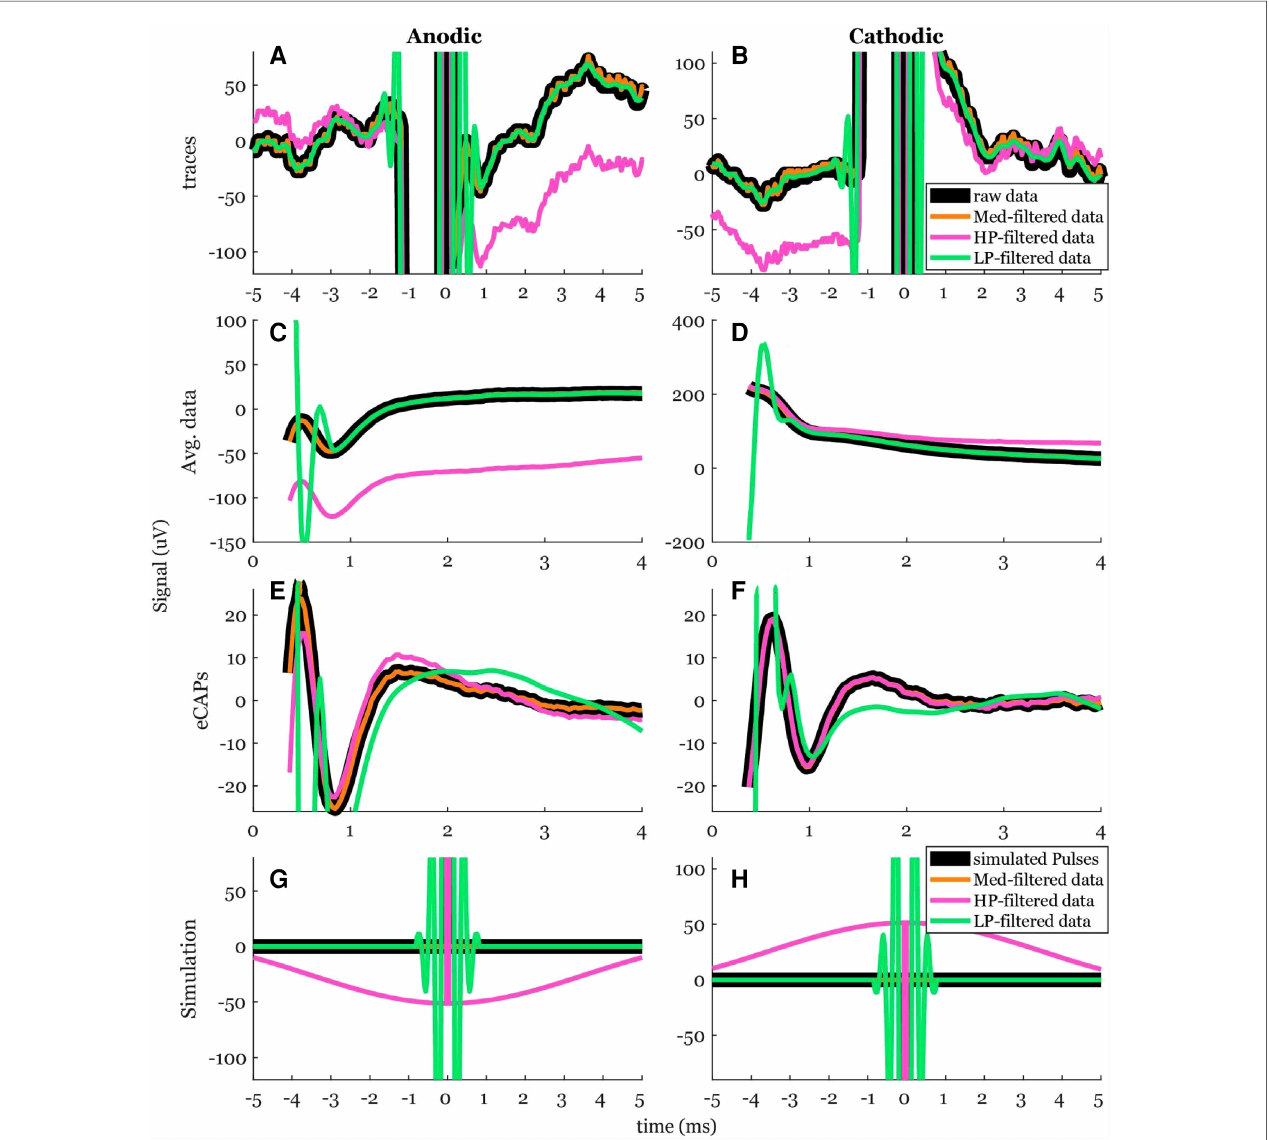
FIGURE 7 The effects of using of fl ine digital fi lters: a median (Med) fi lter with a 100-ms window, a 4th order Butterworth high pass (HP) fi lter with 80-Hz cutoff frequency applied in forward and reverse, and a 50-tap FIR low pass (LP) fi lter with 3 kHz cutoff frequency. ( A,B ) A segment of the time-trace for anodic and cathodic ECAP. ( C,D ) The averaged data. ( E,F ) The resulting anodic and cathodic ECAP using exp2 fi t. ( G,H ) The effects of each fi lter on an impulse function in